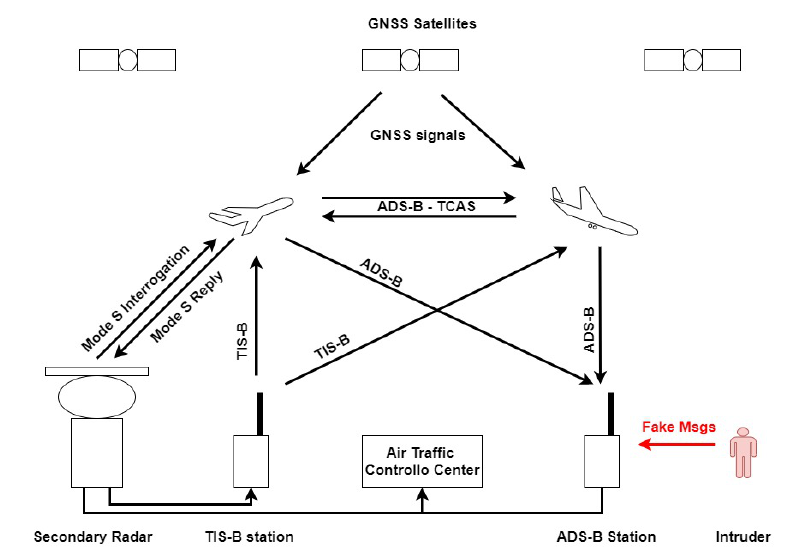
Figure 1. Secondary Surveillance Radar (SSR) Modes, Automatic Dependent Surveillance System (ADS-B), Traffic Information System (TIS-B), and Traffic Collision Avoidance System (TCAS) block diagram. Intruder is also